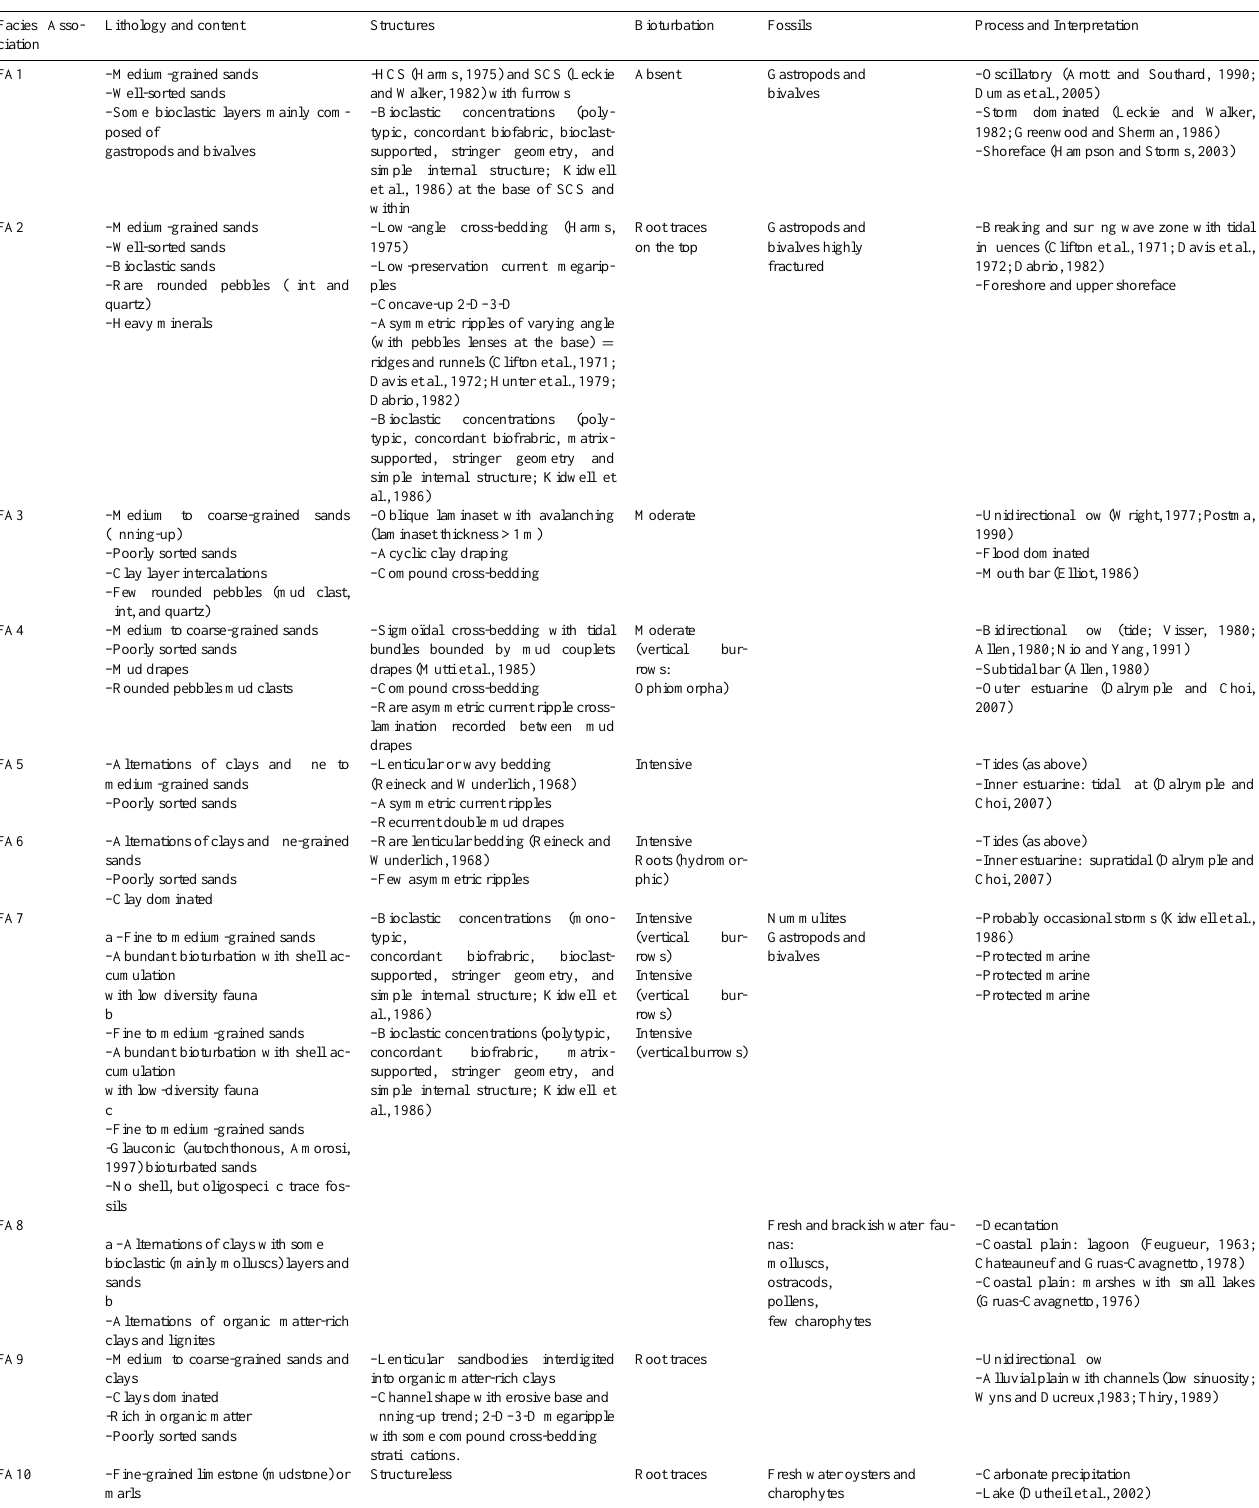
Table 1. Facies description and